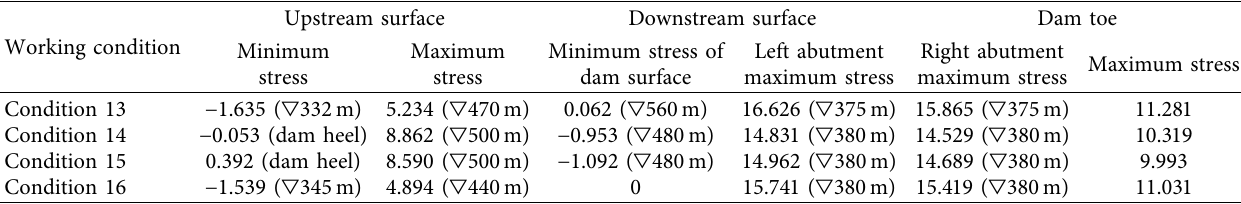
Table 7: Characteristic stress value of arch dam under special load combination (unit: MPa).